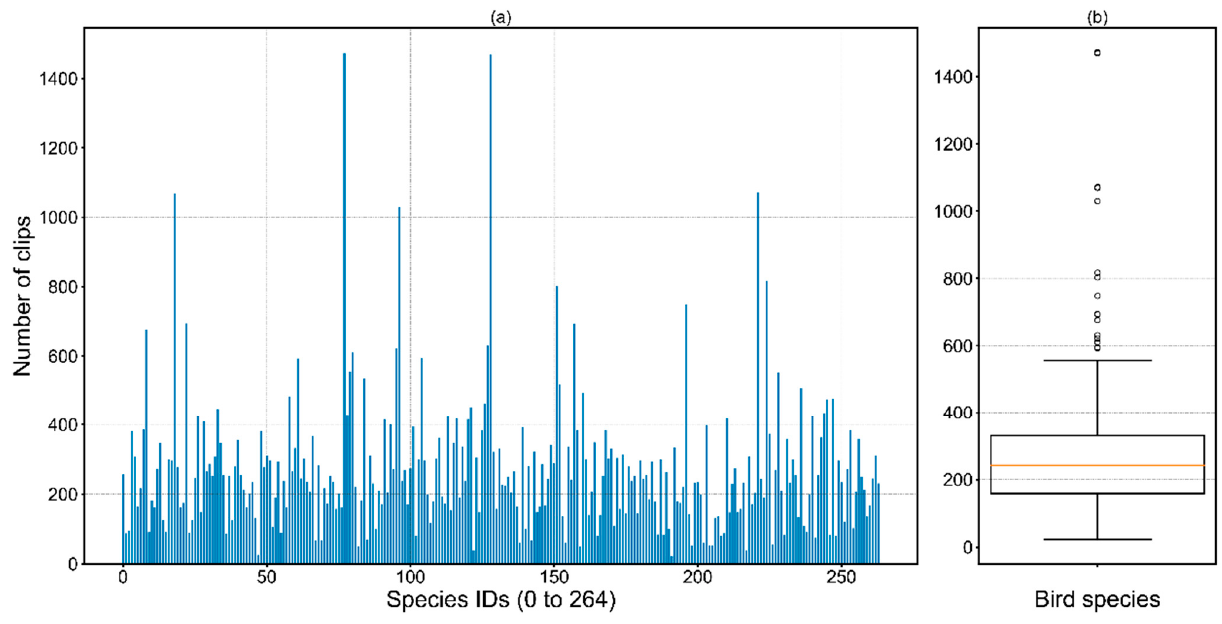
Figure 1. Distribution of bird call clips. ( a ) Overview of distribution of bird call clips, ( b ) Statistics: Num max = 1472, Num min = 23, Num std = 196, Num avg = 273.